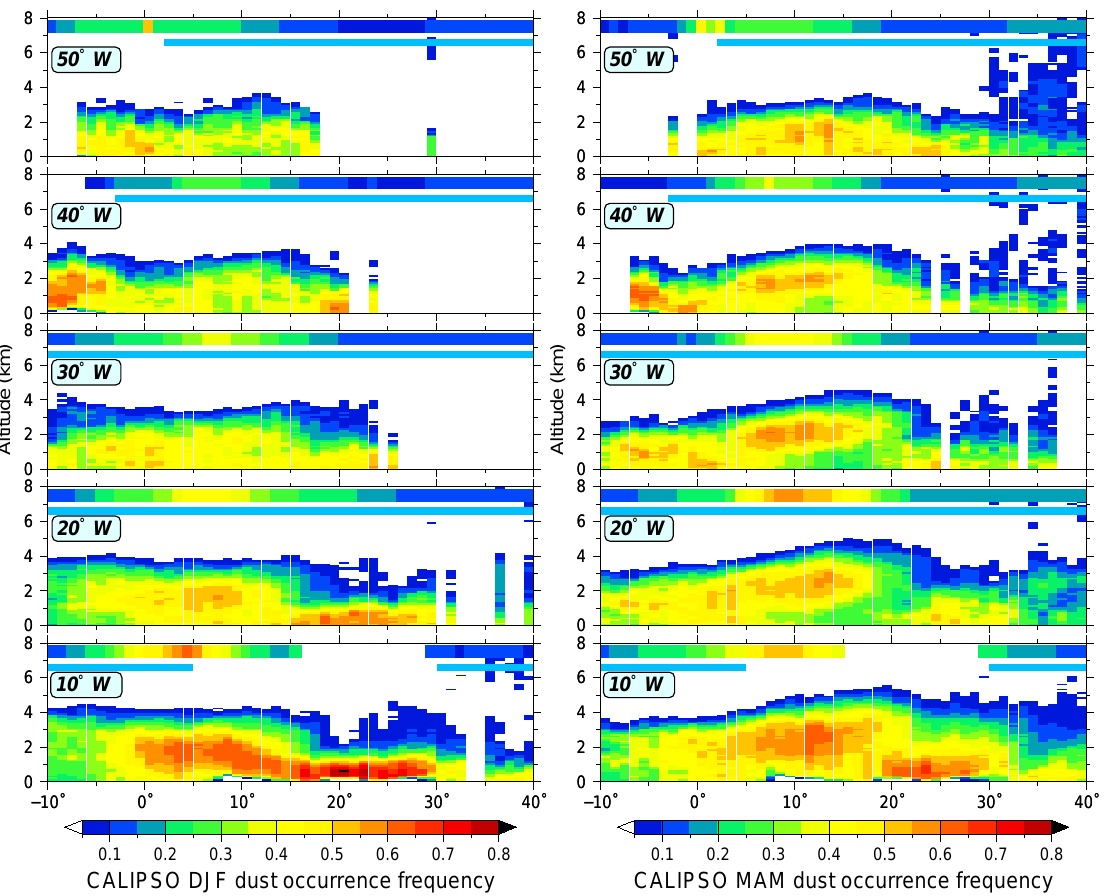
Fig. 3. Vertical distribution of the dust aerosols occurrence frequency above the Atlantic Ocean at five longitudes (10, 20, 30, 40 and 50 ◦ W) during winter (DJF – left) and spring (MAM – right) seasons from 5 yr of CALIPSO observations. The abscissa is the latitude from 10 ◦ S to 40 ◦ N. The cyan line at 6.5km of each cross section marks the ocean, while the color line above it, between 7 and 8km, is the MODIS AOD at 550nm. The colorbar of MODIS AOD is the same as that of the dust occurrence frequency.